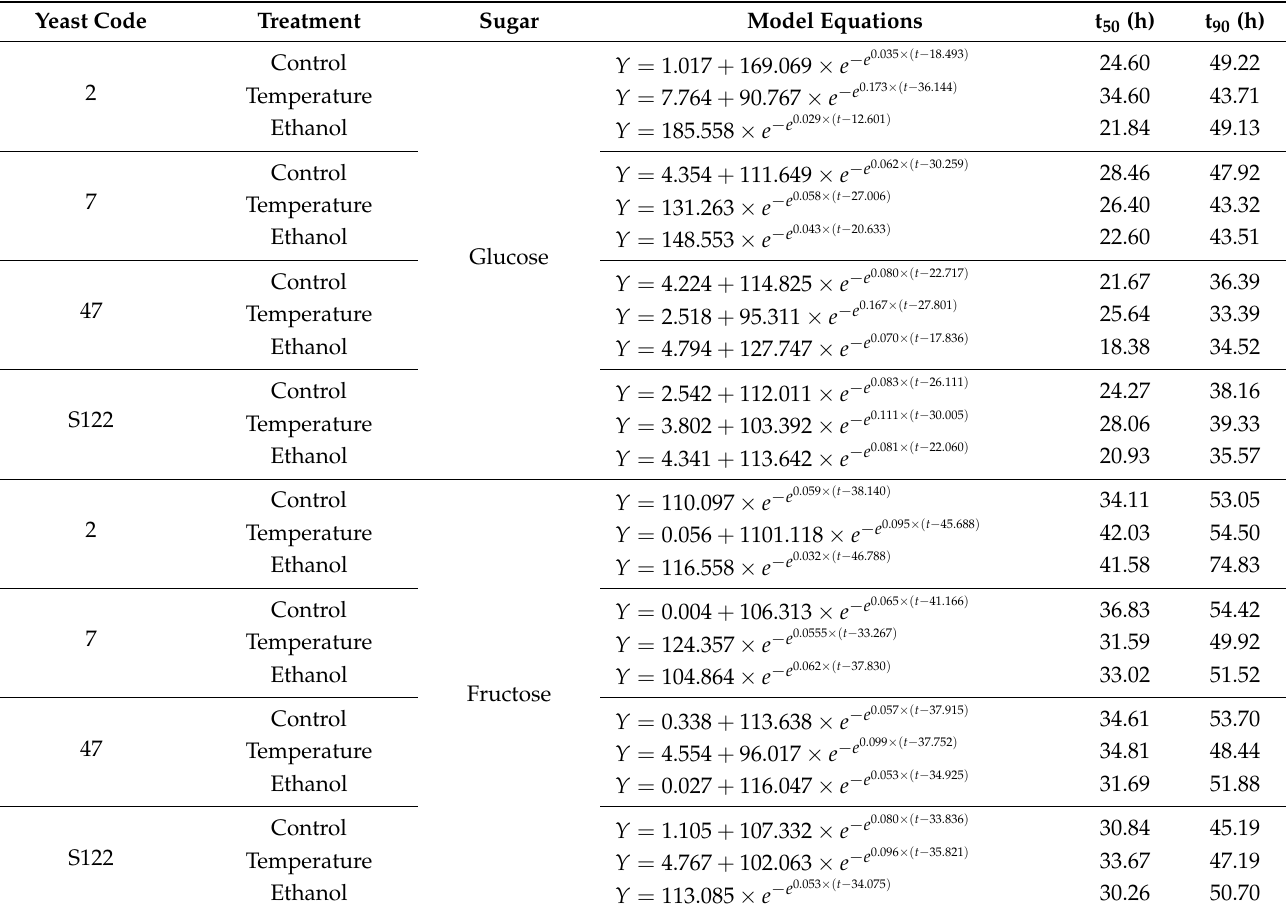
Table 5. Equations (sigmoidal model) to estimate the residual glucose and fructose content (g/L) in synthetic must fermented by the tested yeast strains either untreated (control) and subjected to temperature or ethanol pretreatment. The time needed to consume 50% (t50) and 90% (t90) of the initial sugar concentration in each condition is also